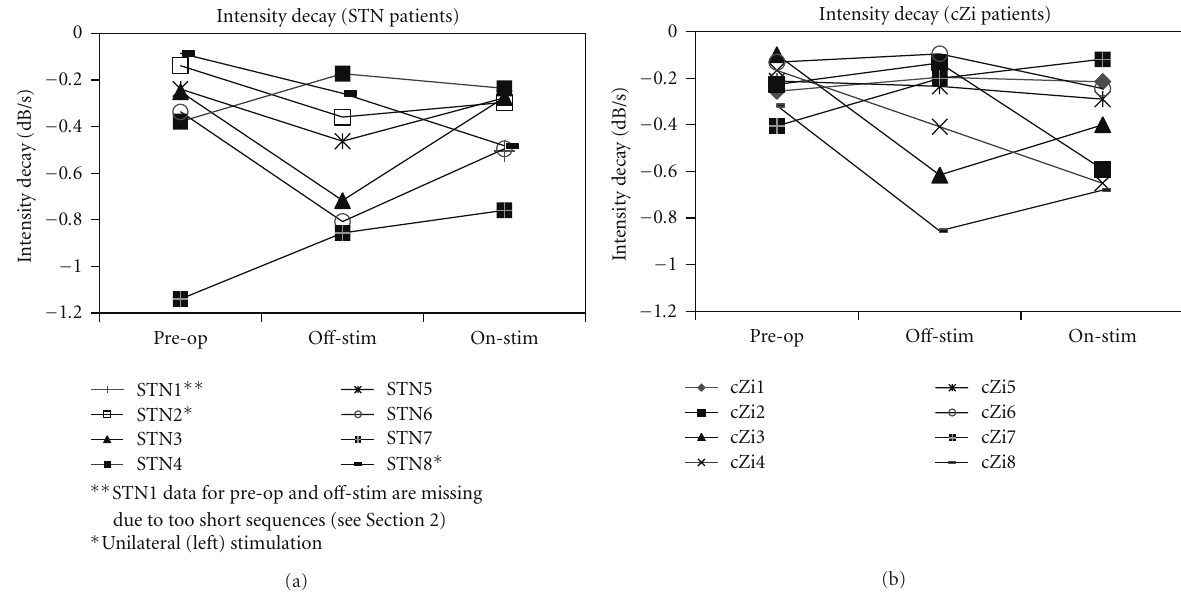
Figure 4: Intensity decay during syllable repetition for individual patients in STN and cZi